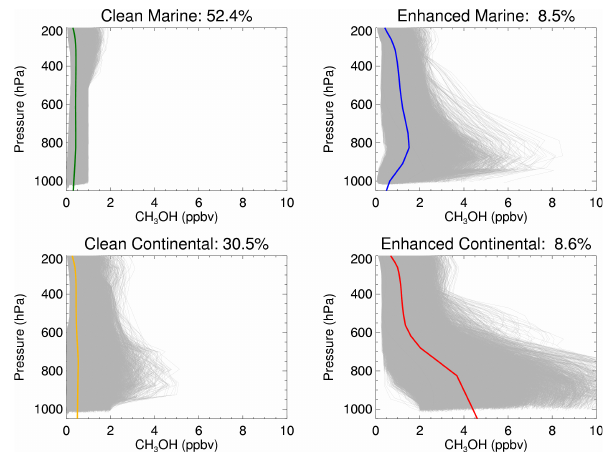
Fig. 3. Methanol profiles simulated by GEOS-Chem over the entire globe for 2004 binned by type (in grey). The mean profiles for each category, shown in color, are used as a priori profiles in the TES methanol retrieval. See text for